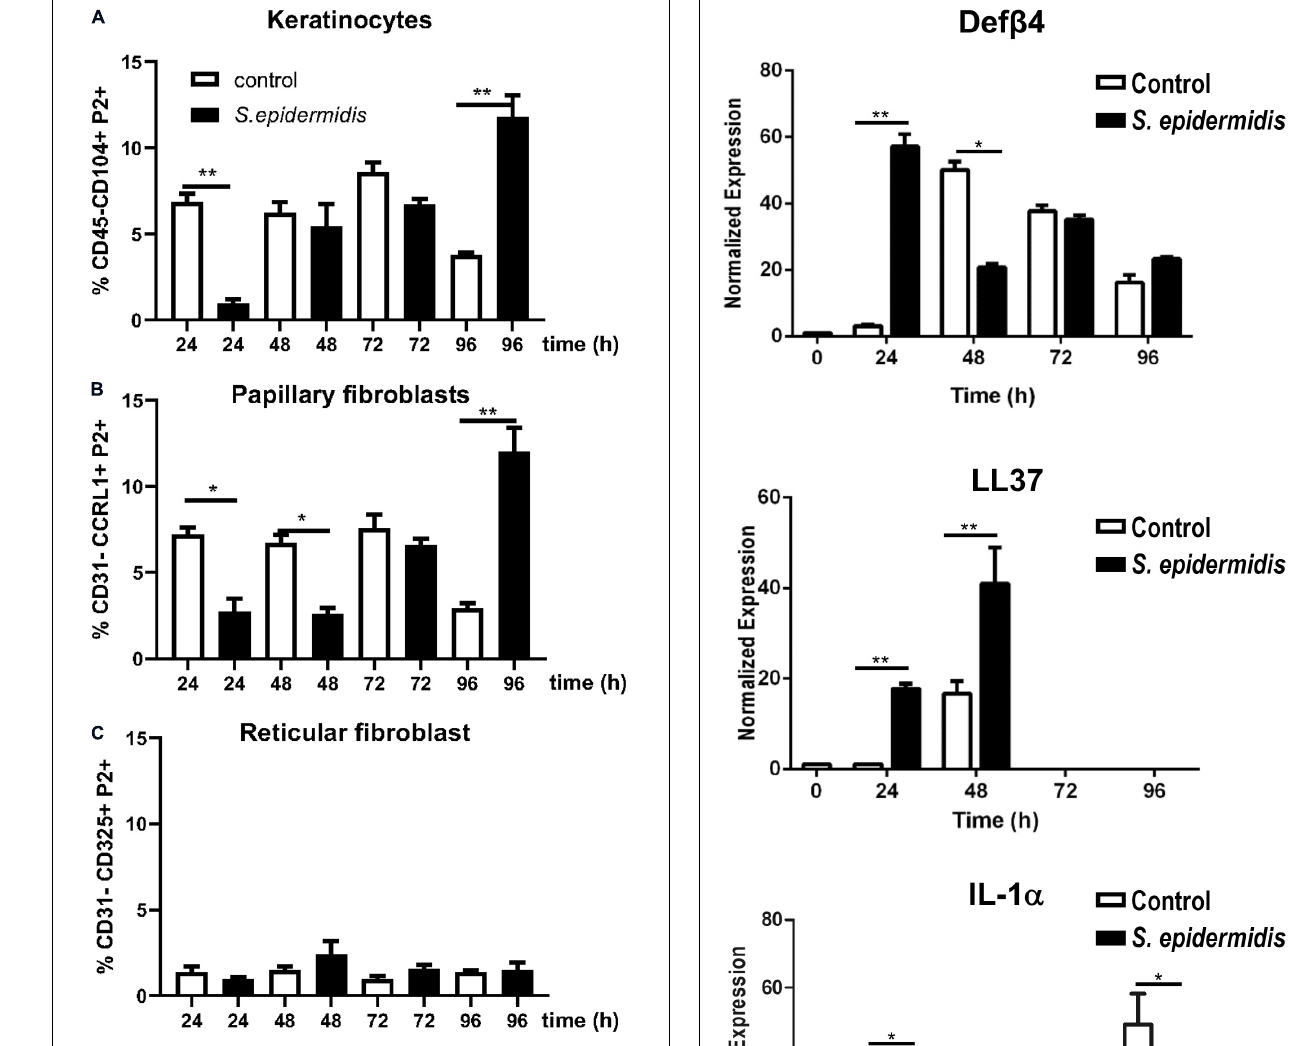
FIGURE 3 | Staphylococcus epidermidis colonization induces P-2 in human keratinocytes and papillary fibroblasts. Control, non-colonized, and S. epidermidis colonized human skin was maintained at air liquid interface and collected at indicated time points (24, 48, 72, and 96 h) for FISH-Flow. Single cell suspensions were labeled with live/dead stain. Using FISH-Flow RNA assay, P-2 RNA levels were analyzed in (A) CD45-, CD31-, CD104+ cells (keratinocytes), or (B) CD45-, CD31-, CCRL1+ (papillary fibroblasts), and (C) CD45-, CD31-, CD325+ cells (reticular fibroblasts). Bar graphs show percentage of P-2 mRNA positive cells within each CD45-CD31-skin cell population. Data represent at least two experiments with three independent